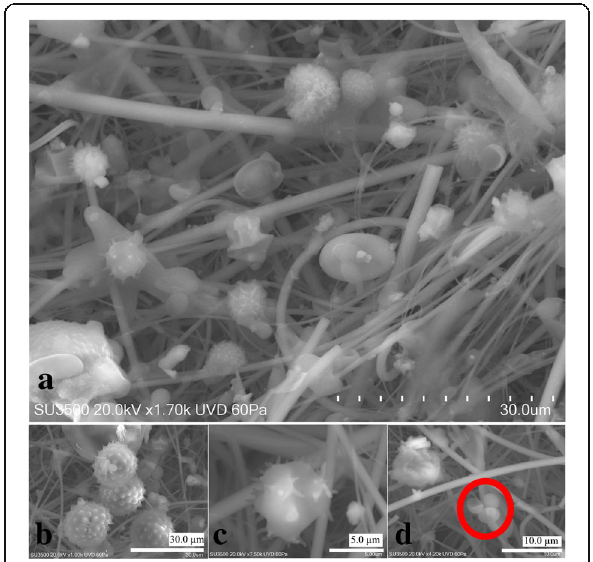
Fig. 11 Examples of organic particles in the samples obtained in September 2014 at the GD site. a A SEM image of the wide visible range. b Pollen. c Spore. d Microorganisms (surrounded by red circles)